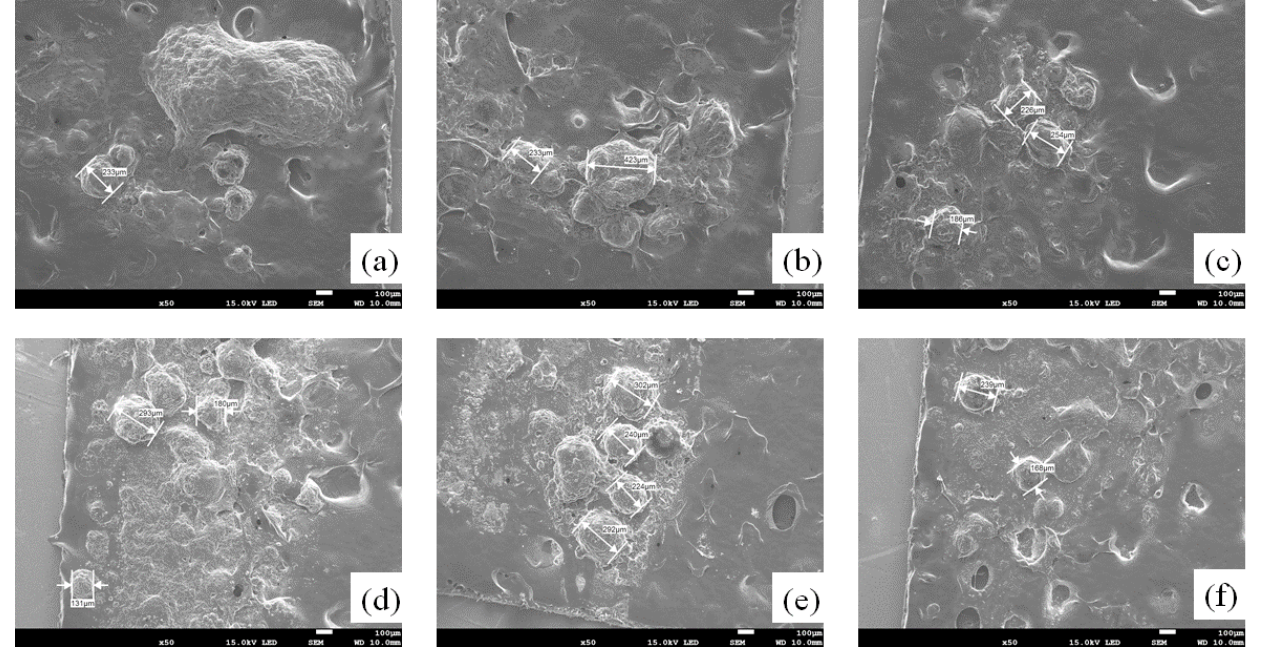
Figure 12. SEM images of different steel ball size ratios. ( a ) Ball milled powder with steel balls ratio 1:1; ( b ) ball milled powder with steel balls ratio 1:2; ( c ) ball milled powder with steel balls ratio 1:3; ( d ) ball milled powder with steel balls ratio 1:4; ( e ) ball milled powder with steel balls ratio 1:5; ( f ) ball milled powder with steel balls ratio 1:6.